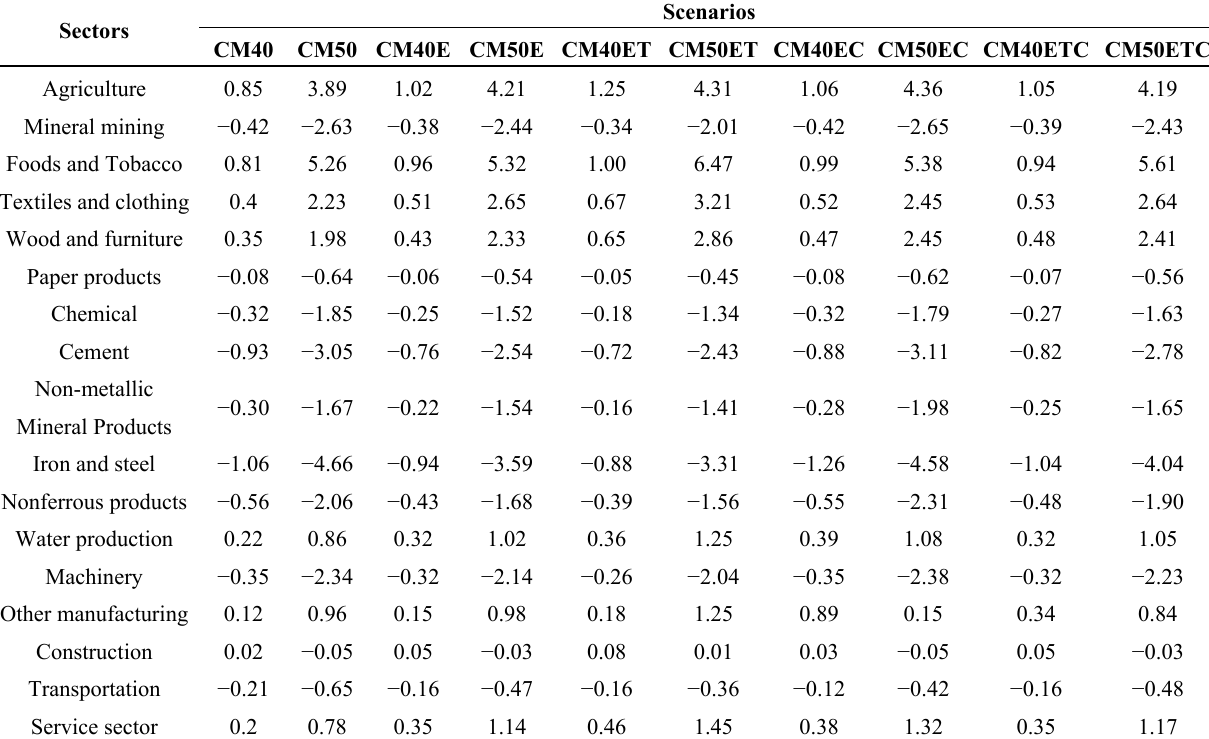
Table 6. Change of activity level in various scenarios in 2050 compared with BAU (%). Sectors